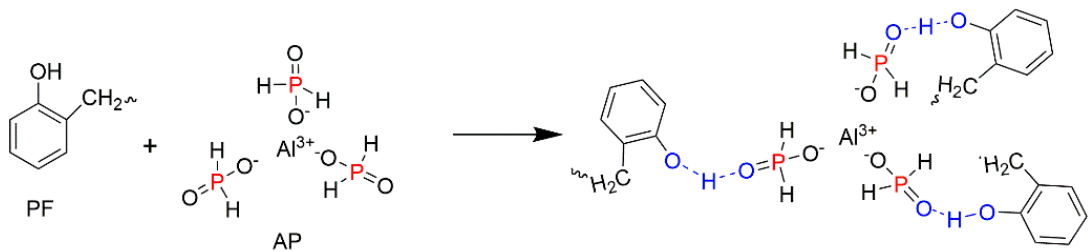
Figure 8. An interaction of phenolic resin (PF) with AP through hydrogen bonding in the PF/AP formulation [68].